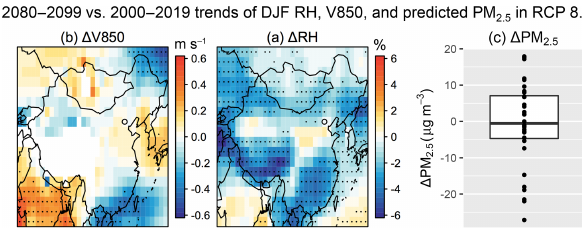
Figure 5. Projecting the effect of 21st century climate change (2080–2099 vs. 2000–2019) on Beijing winter haze. Results are for mean wintertime changes ( (cid:49)) of (a) meridional wind veloc- ity at 850hPa (V850) and (b) surface relative humidity (RH) in the RCP8.5 climate change scenario from an ensemble of 32 cli- mate models on a 2 ◦ × 2.5 ◦ grid (Table S2). Grid boxes in which more than 70% of the models show a consistent sign of change are stippled. The location of Beijing is indicated with a circle. (c) Pre- dicted changes of mean wintertime PM 2 . 5 in Beijing from individ- ual CMIP5 models (symbols), using the first principal component of V850 and RH (PC1) as a proxy and assuming present-day emis- sions. The top and bottom of the box are the 25th and 75th per- centile, and the centerline is the 50th